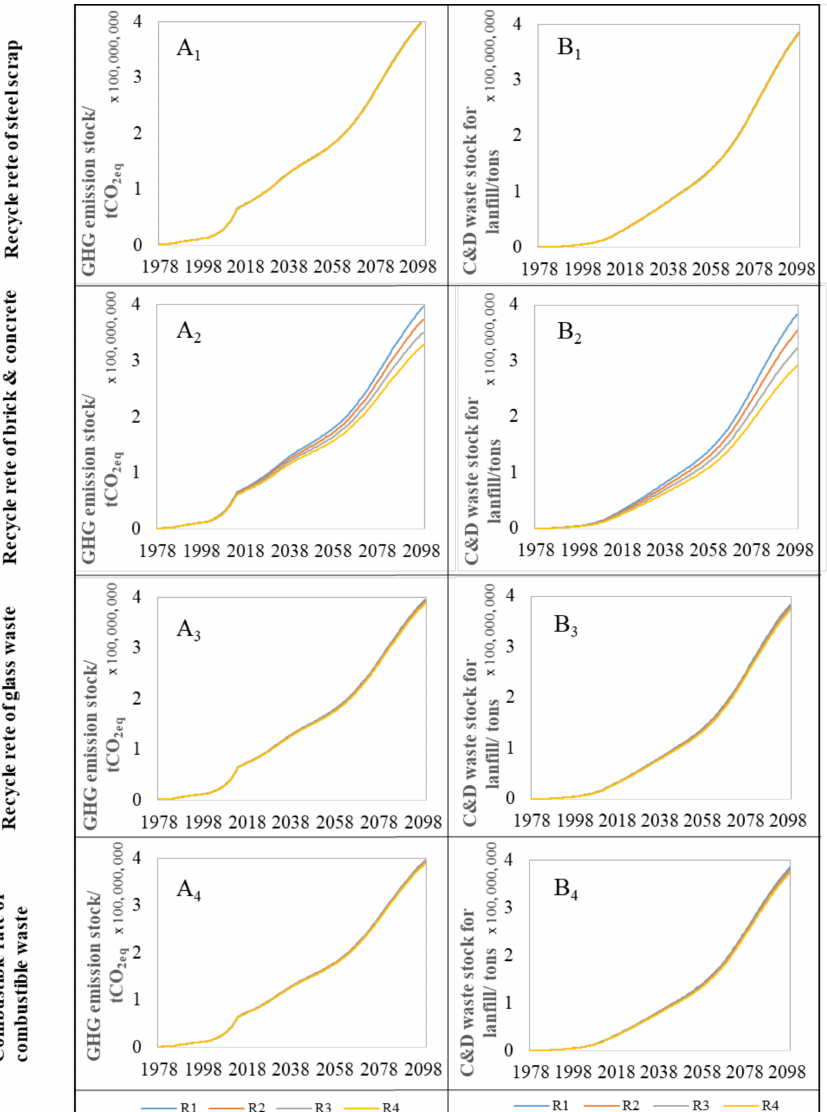
Figure 11. The simulation of the sensitive analysis. A 1 , A 2 , A 3 and A 4 represent the impacts of different recycle rate of scrap steel, different recycle rate of brick & concrete, different recycle rate of glass waste and different combustible rate of combustible waste on GHG emission stock. B 1 , B 2 , B 3 and B 4 represent the impacts of different recycle rate of scrap steel, different recycle rate of brick & concrete, different recycle rate of glass waste and different combustible rate of combustible waste on C&D waste stock for